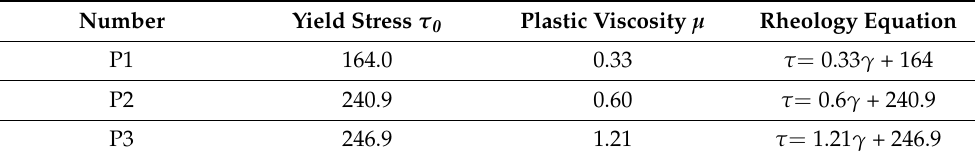
Table 4. Rheological equation of ECC prepared with different types of fly